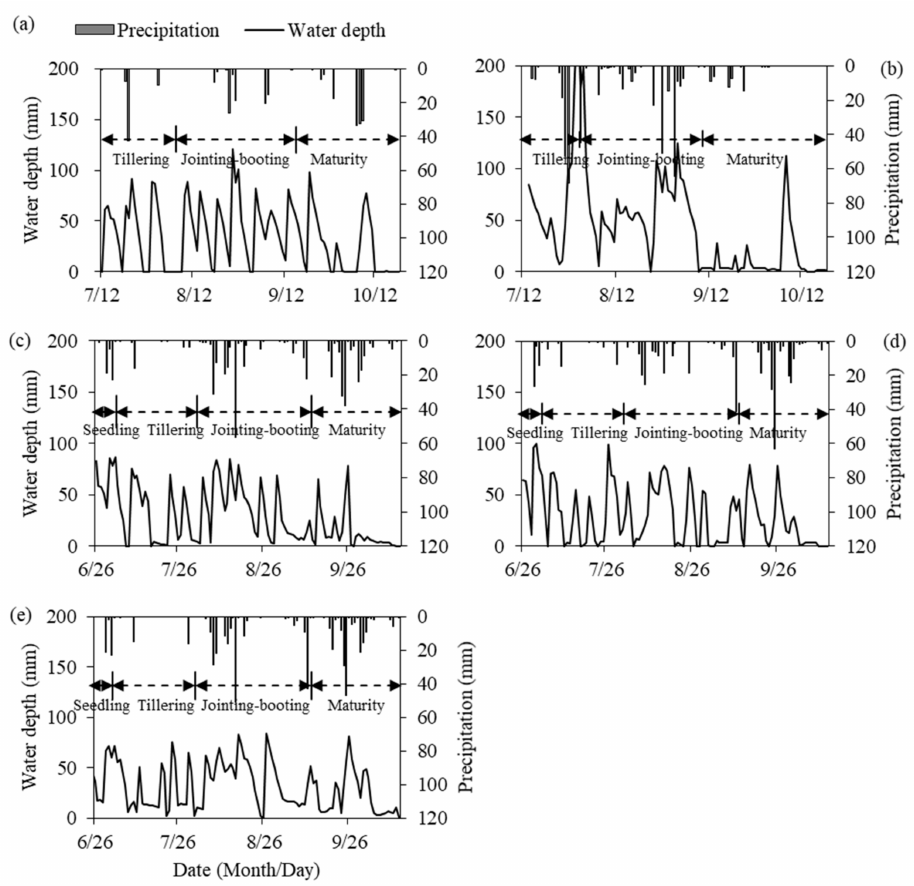
Figure 2. Growing period, paddy water depth and precipitation hydrograph of the paddy field. ( a ) LC13, ( b ) LC14, ( c ) ZT, ( d ) HQ, ( e )